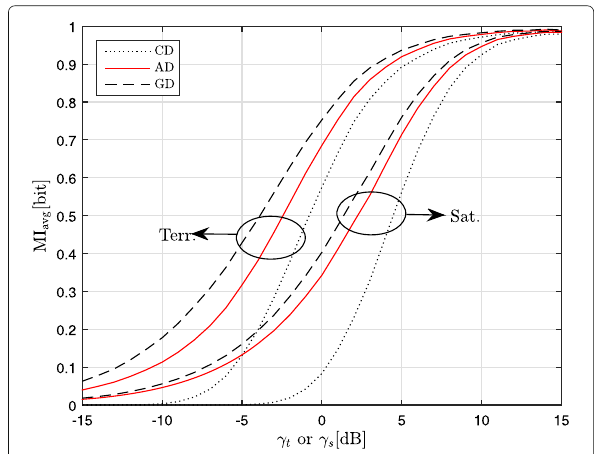
Fig. 3 Comparison of detection strategies for the terrestrial and satellite channel (2-PAM, N U = N T = 7, θ =